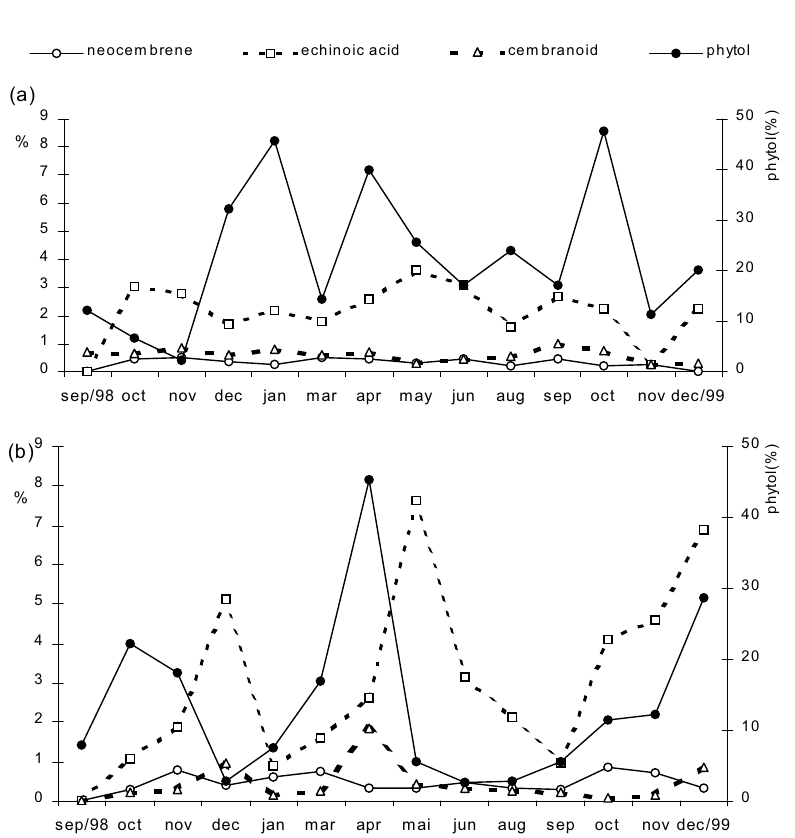
Fig. 2 – Monthly variability of the major diterpene constituents of the E. grandiflorus essential oil from the SL (a) and BL (b) populations (% of chromatogram